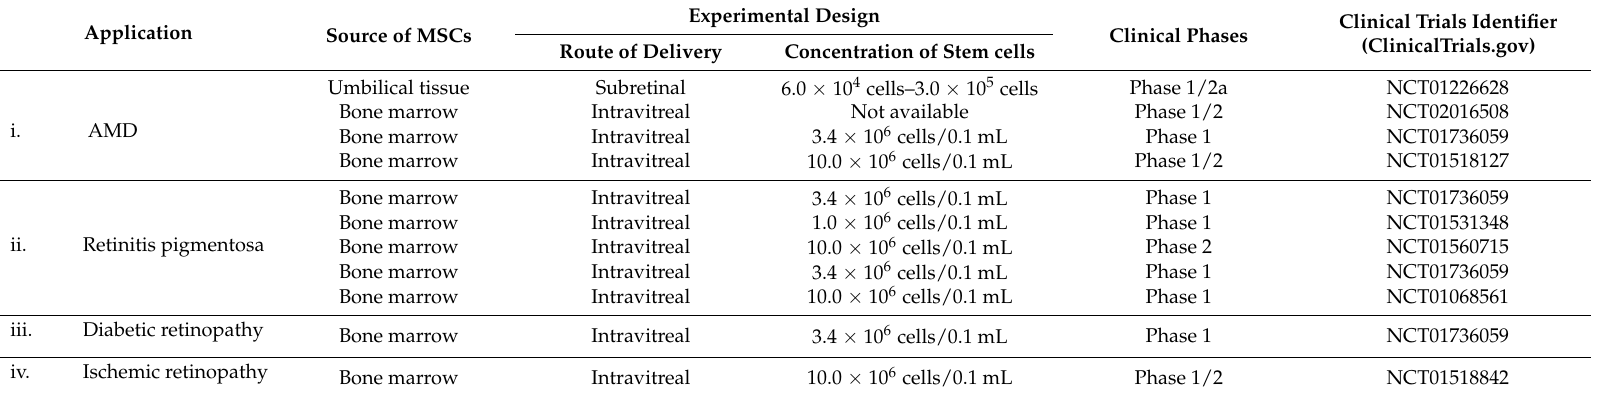
Table 2. Current clinical trials using MSCs for the treatment of retinal